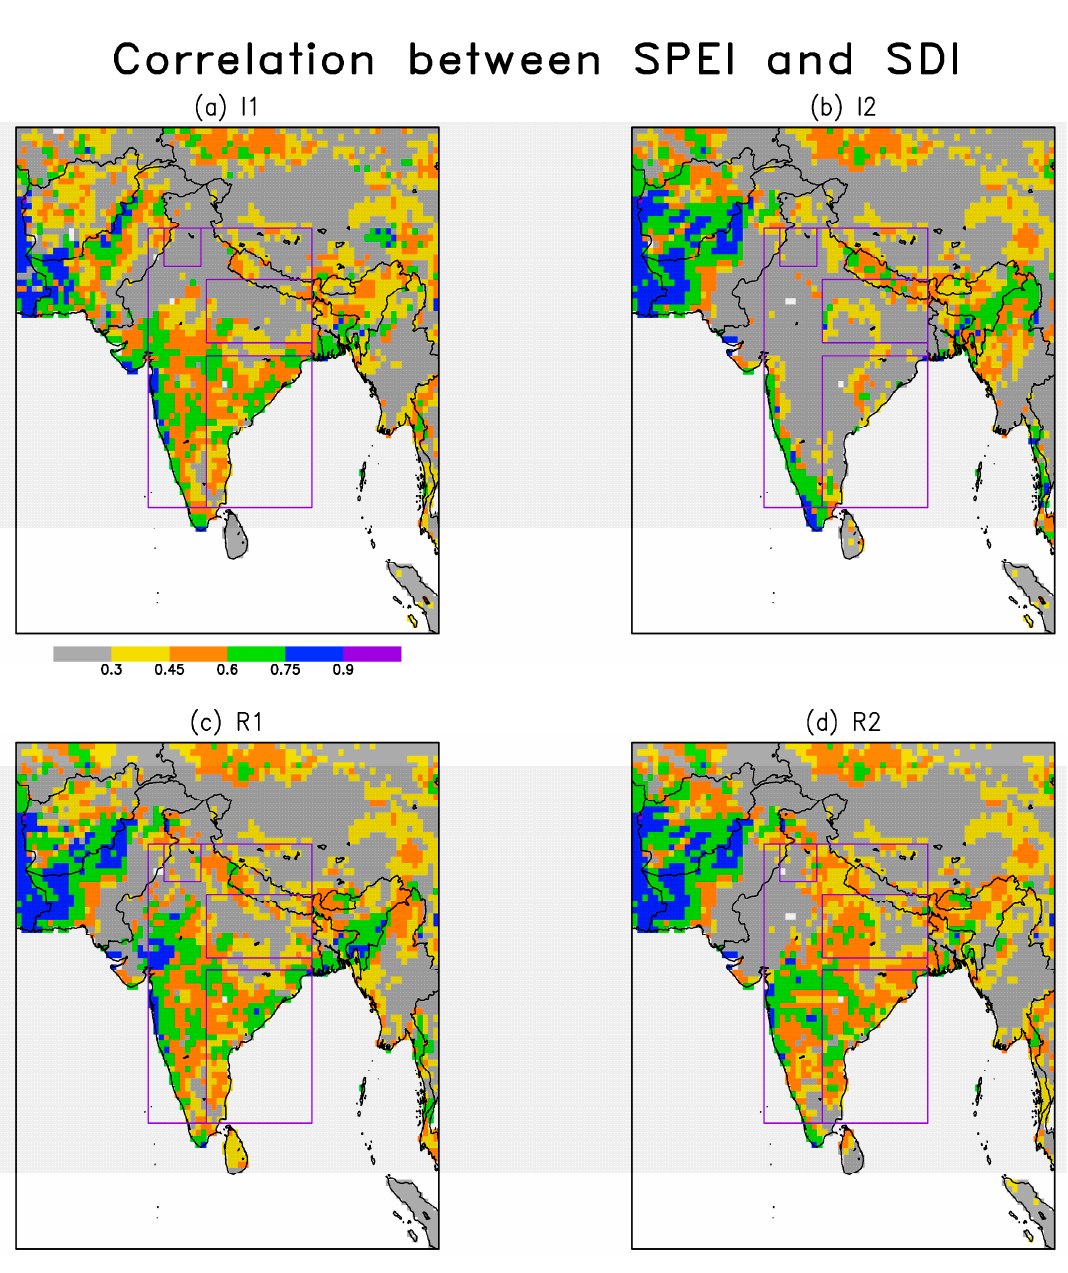
Figure 5. Linear correlation coefficients between local water balance anomaly indicator (SPEI) and non-local freshwater anomaly estimator (SDI) for each cropping cycle: ( a ) I1—Kharif irrigated; ( b ) I2—Rabi/summer irrigated; ( c ) R1—Kharif rainfed/flooded; and ( d ) R2 Kharif rainfed/flooded. The boxes highlight the same regions as in Figure 2.